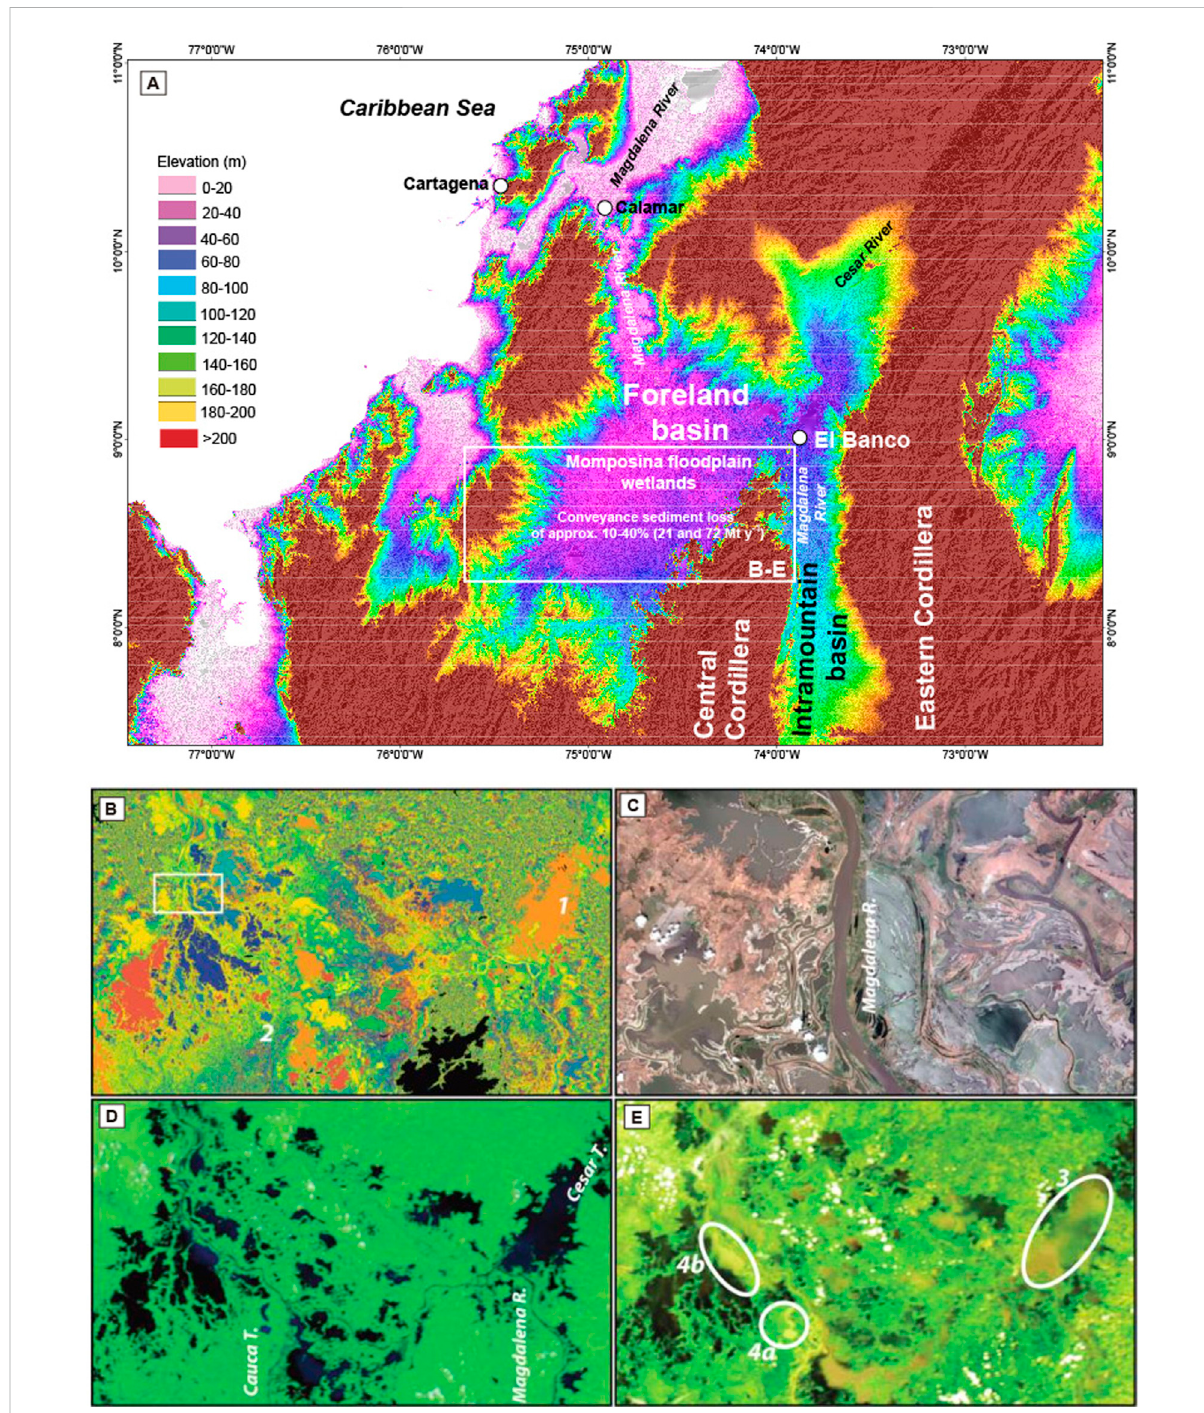
FIGURE 2 (A) Multi-Error-Removed Improved-Terrain DEM of the lower reaches of the Magdalena drainage basin (Data courtesy of Dai Yamazaki, Yamazakietal.,underreview). (B,D,E) Representationsofthesameareaandadetailedview (C) oftheMomposina fl oodplainwetlands(modi fi edfrom Kettner et al., 2010). (B) Display of 1-m vertical intervals of space shuttle radar topography mission data obtained during 11-day mission in February 2000(i.e.,duringthedryseason).Eachcolorrepresentsa1-minterval;lakesborderingtheMagdalenaRiveraswellastheCesar1)andtheCauca 2) tributaries are shown. (C) Digital Globe 2009 (Google Earth) detailed view [contents of the white box in (B) ] of the lakes created as a result of the tectonic depression. (D) Near-infrared aqua moderate resolution imaging spectroradiometer (MODIS) satellite image during the La Niña event on 10 September 2008. Black shading indicates bodies of water surrounding the Magdalena River and the Cesar and Cauca tributaries. (E) True-color MODISsatelliteimages[samedayandtimeasimagein (D)